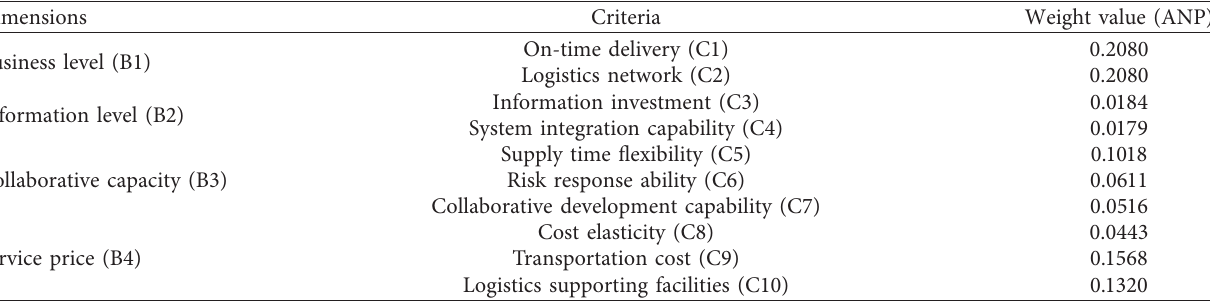
Table 7: The weight value of each index.